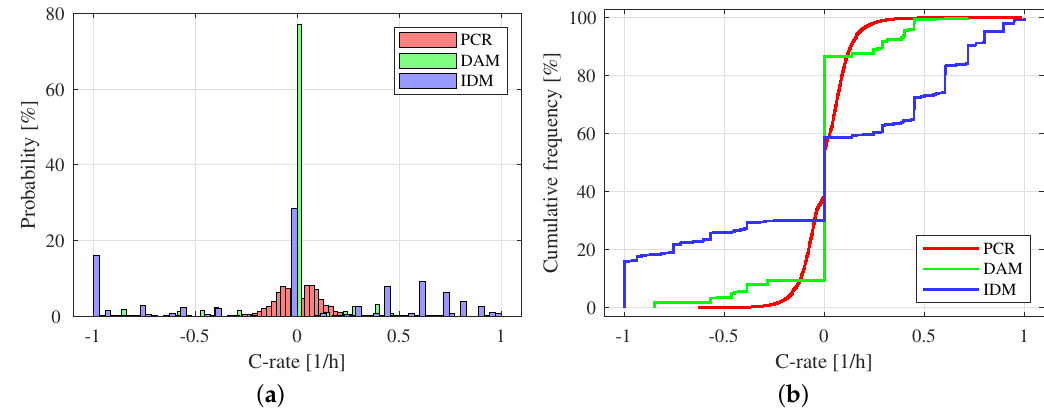
Figure A3. For PCR, DAM, and IDM in the Case 3 scenario (considering all losses and ageing): ( a ) Histogram plots; and ( b ) cumulative distribution. Table A3. Table of efficiencies concerning real-world data. Application and